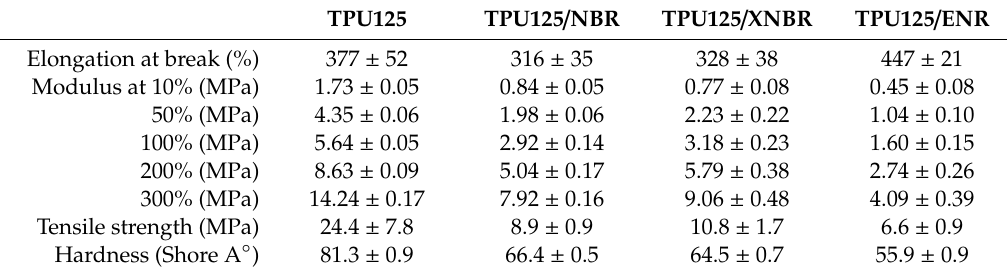
Figure 8. Typical tensile curves of the TPU matrix and the TDVs. Table 1. Mechanical properties of the TPU matrix and the TDVs.